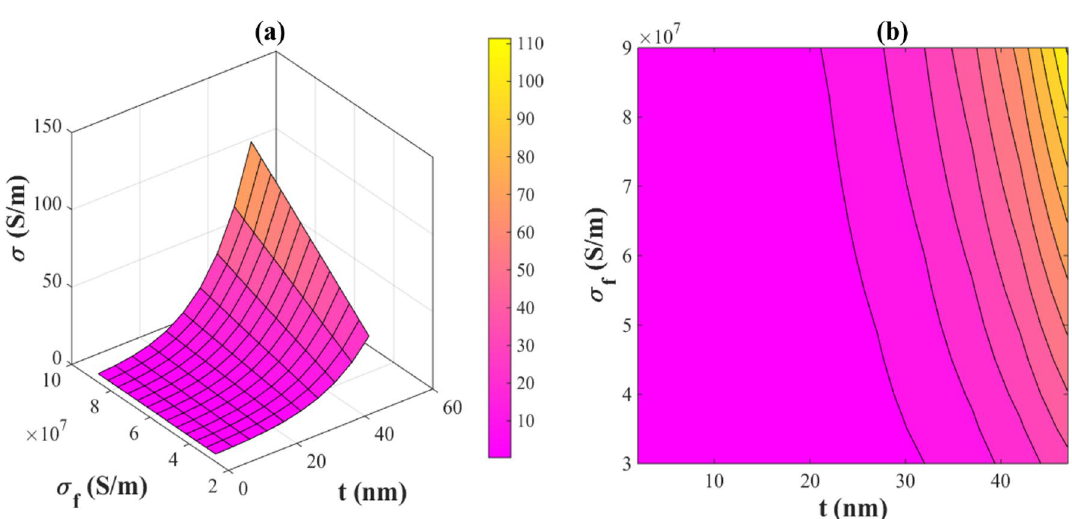
Figure 6. The influences of “t” and “σ f ” on the electrical conductivity of PNCs by ( a ) 3D and ( b ) contour